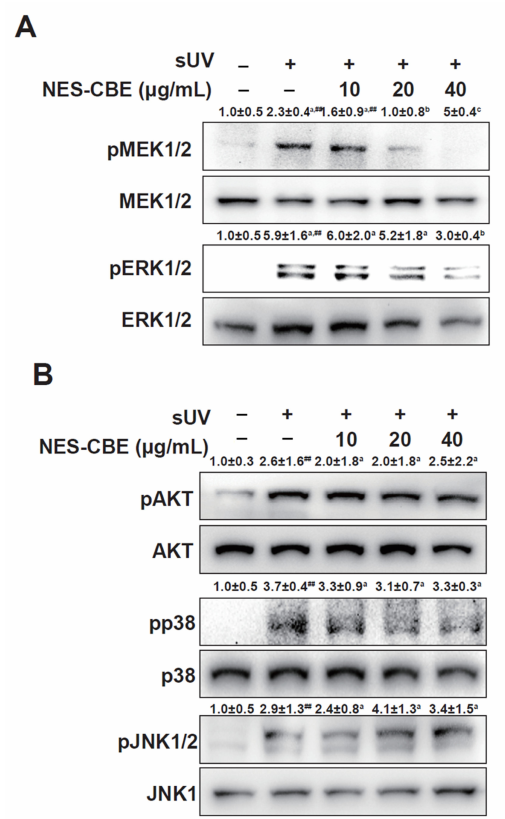
Figure 4. Inhibitory effect of NES-CBE on the sUV-induced MEK/ERK signaling pathway. ( A ) Effect of NES-CBE on the sUV-induced ERK1/2 signaling pathway. ( B ) Effect of NES-CBE on the sUV- induced Akt, p38 and JNK1/2 signaling pathways. HaCaT cells were treated with NES-CBE at the indicated concentration for 1 h, treated with sUV for 30 min. The cell lysates were prepared for western blotting. Image Studio software (LI-COR, Lincoln, NE, U.S.A.) was used for band density measurement. Bands are normalized to that of non-phospho form. Data are means ± SD of at least three independent experiments. ## Significant difference between the control and sUV-treated groups ( p < 0.01), one-way ANOVA. Duncan’s Multiple Range test was used as a post hoc test to measure specific differences. Different letters indicate a significant difference at p <